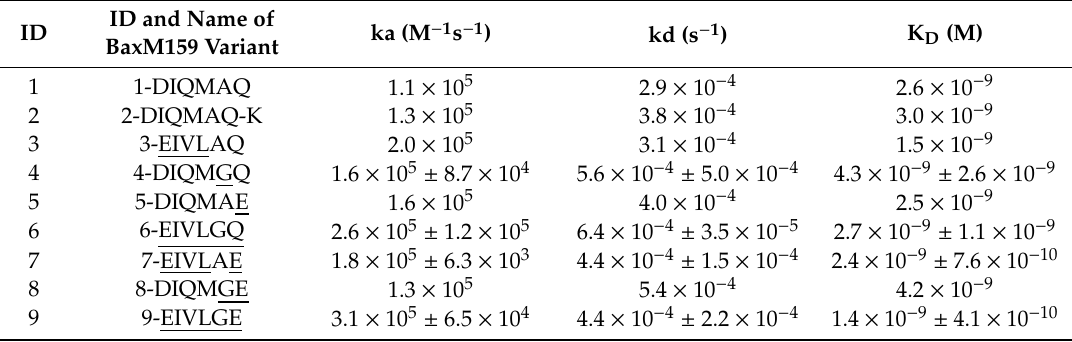
Table 2. A ffi nity of BaxM159 variants determined by surface plasma resonance. The surface plasma resonance analysis was repeated twice except for indicated antibody variants. Standard deviation of ka, kd, and K D is indicated.